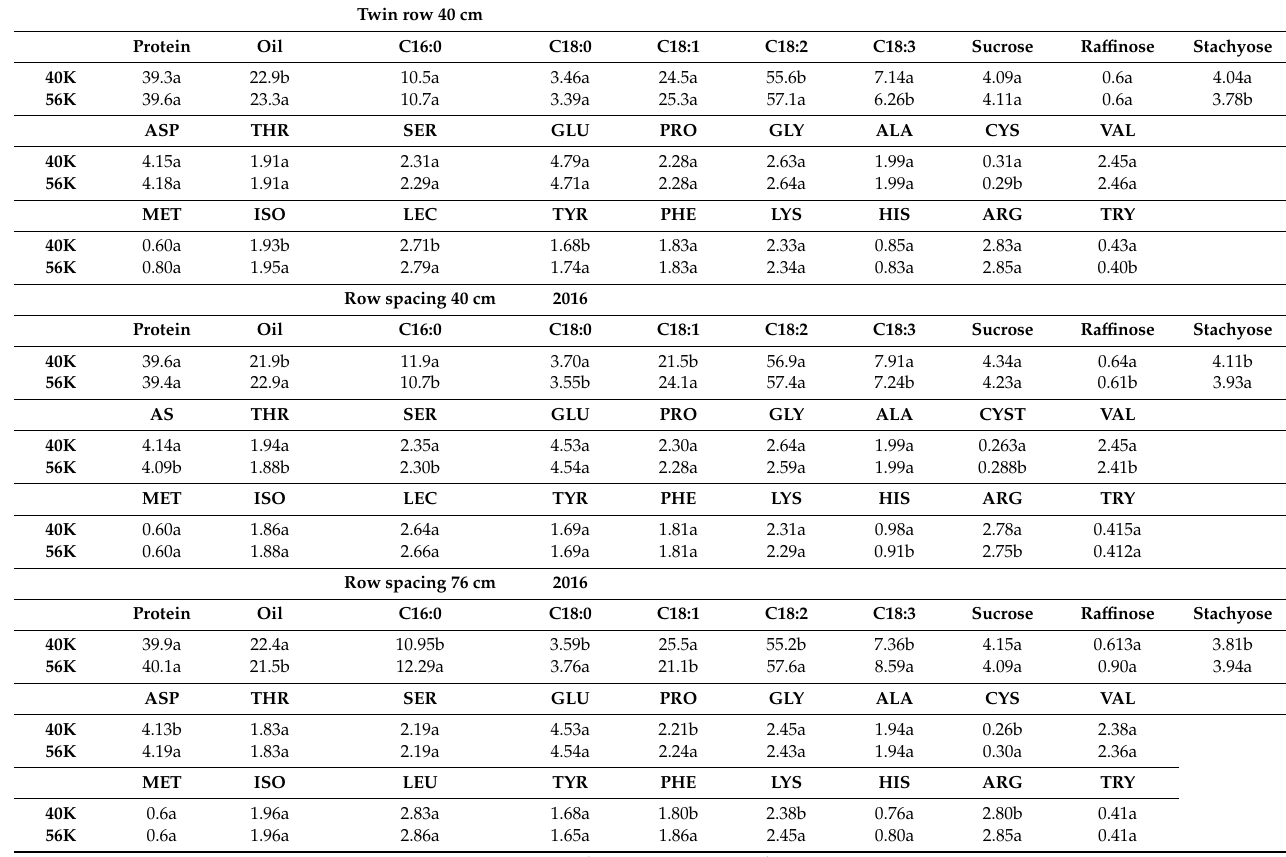
Table 6. The e ff ect of seeding rate and row spacing (15 inches twin row, 15 row spacing, and 30 row spacing (40 cm and 76 cm, respectively) on seed composition (protein; oil, palmitic (C16:0); stearic (C18:0); oleic (C18:1); linoleic (C18:2); linolenic (C18:3); sugars (sucrose, ra ffi nose, stachyose) (%); and amino acids aspartic acid (ASP), threonine (THR), serine (SER), glutamic acid (GLU), proline (PRO), glycine (GLY), alanine (ALA), cystine (CYS), valine (VAL), methionine (MET), iso-leucine (ISO), leucine (LEU), tyrosine (TYR), phenylalanine (PHE), lysine (LYC), histidine (HIS), arginine (ARG), and tryptophan (TRY) (%) in cultivar AG 4632, in 2016. Twin row 40 cm